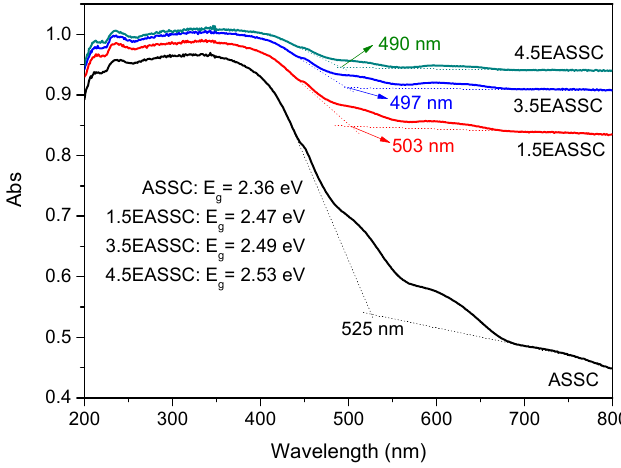
Figure 4. UV–vis diffuse reflectance spectra of specimens.